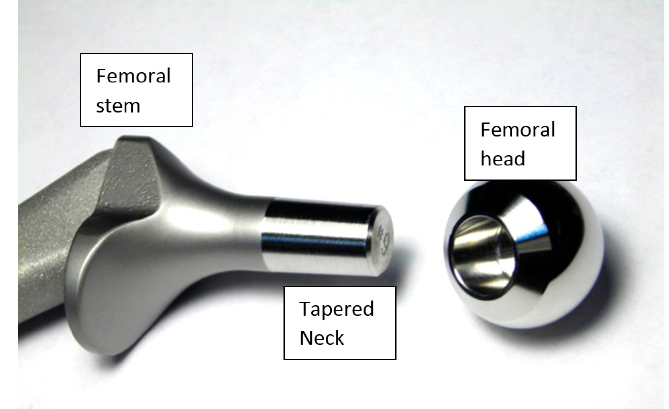
Figure 1. Sample of modular total hip replacement (THR).